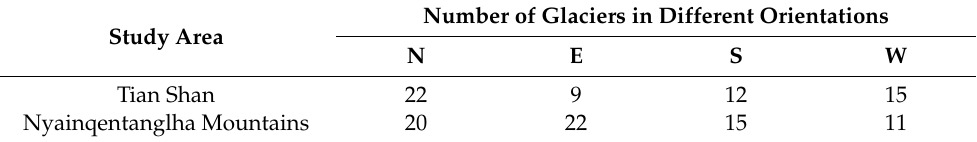
Table 7. The number of glaciers in different orientations in the Tian Shan and the Nyainqentanglha